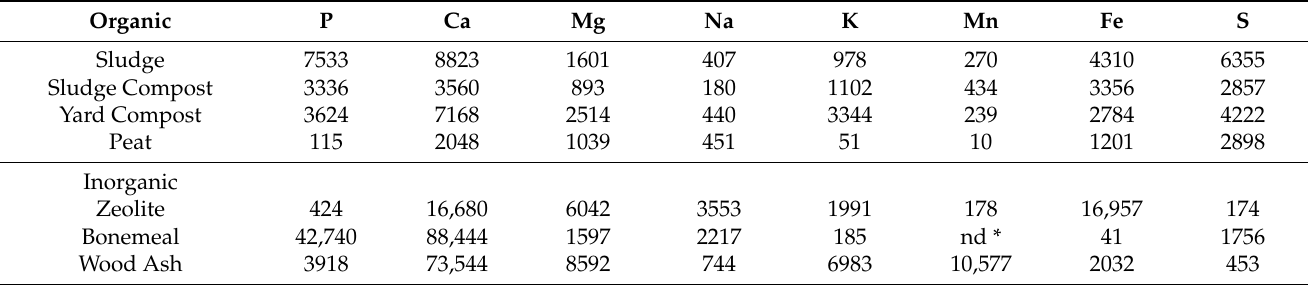
Table 2. Mean elemental (mg kg − 1 ) composition of applied immobilization amendments.